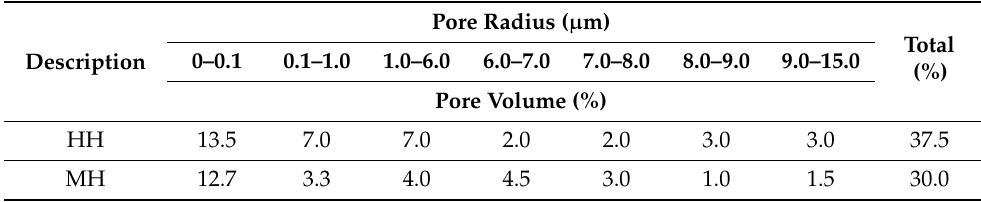
Figure 8. Integral ( a , b ) and differential ( c , d ) characteristics of the porous structure of the investigated HH and MH samples. Table 10. Quantitative distribution of pores in the samples (%) depending upon their radii and the mode of hardening.